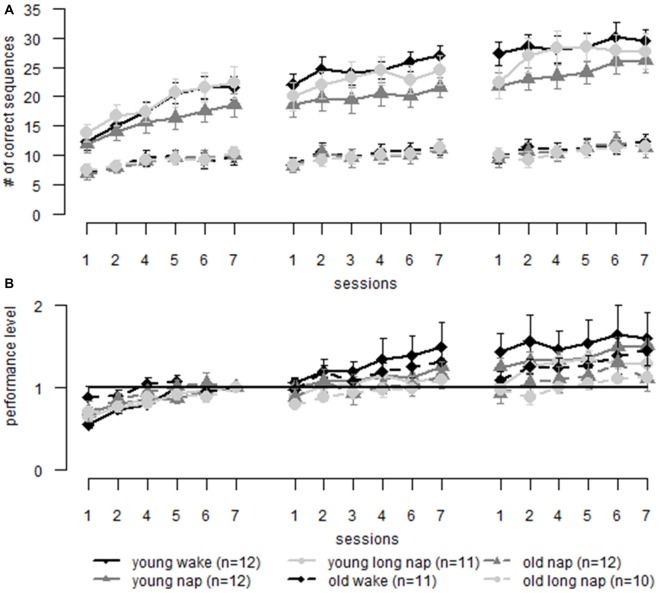
Sequence learning: comparison of learning in older (dotted lines) and younger adults (solid lines) over three learning sessions including a midday break (first gap) and over-night sleep (second gap). (A) Raw data comparing young and older adults. (B) Learning data is normalized to the same pre-sleep level of learning (last block of the first session) in both young and old adults. Error bars represent the standard error of the mean.